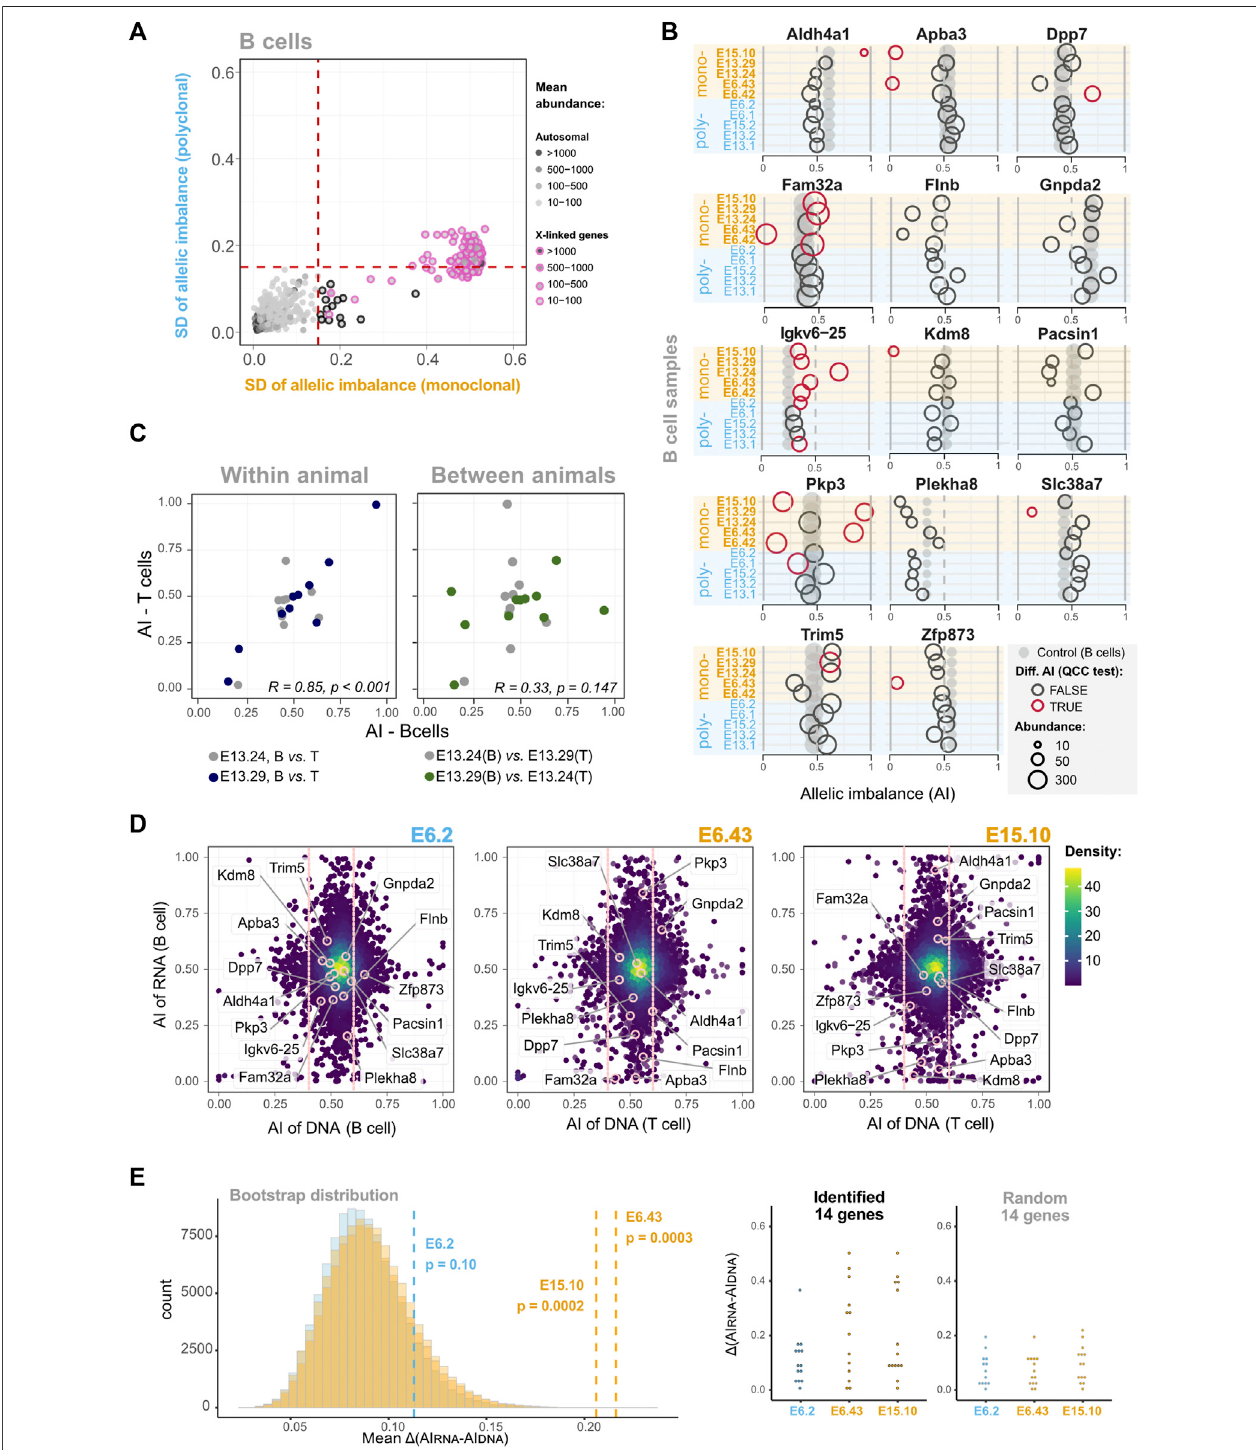
FIGURE 4 | In some loci , the memory of allele-speci fi c gene regulatory state persists over many cell divisions throughout extensive differentiation. (A) Dot plot showingstandarddeviations(SD)ofAIsfor fi veBcellmonoclonalsamples( x-axis )againsttheSDofAIsfor fi vepolyclonalsamples( y-axis ).Dashedverticalandhorizontal lines — arbitrarily set at an AI SD of 0.15 — represent the threshold above which genes were considered as potentially intrinsically imbalanced. Dots represent genes, black-circleddotshighlightgeneswithhigherAIvarianceamongmonoclonalsamplesintheautosomes,whilepink-circleddotsdenotetheX-linkedgenes(control). The genesincluded in thisanalysishave AIdifferences statistically signi fi cantafter QCC correctioninat least onepairwisecomparison (seethematrixof Figure 3B for all